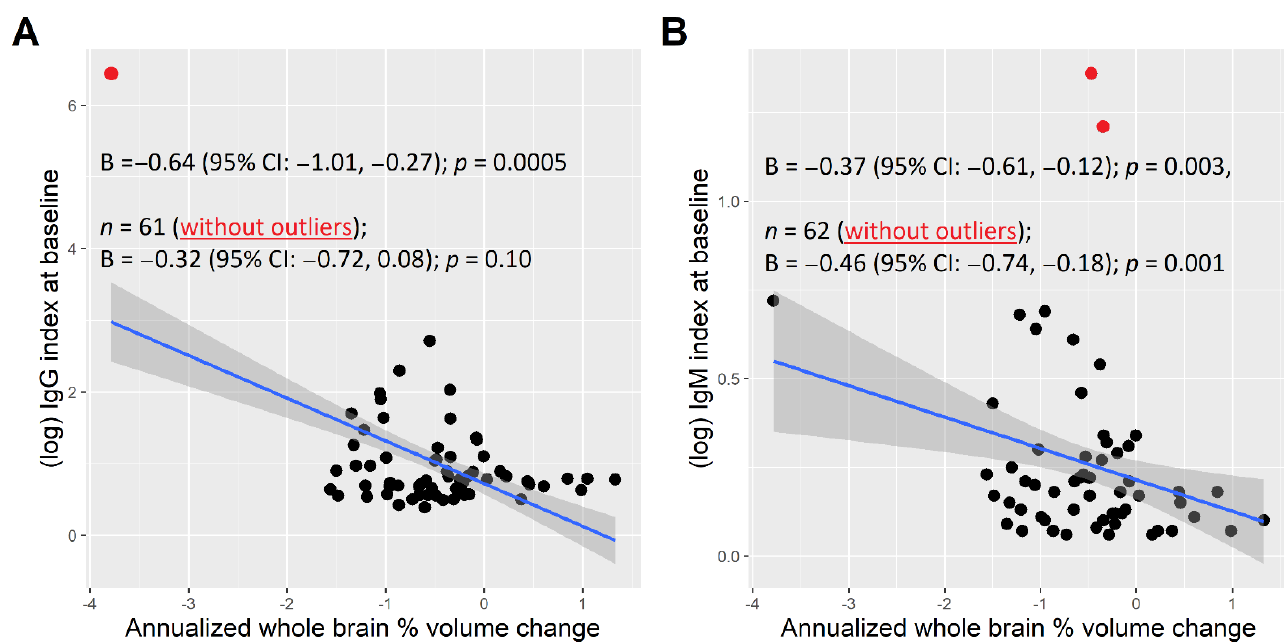
Figure 4. Association between the baseline IgG ( A ) and IgM indices ( B ) and brain % volume loss over the follow − up. Shown are the regression lines (in blue) with the confidence intervals (in grey). The values of the IgG/M indices greater or less than 2.0 standard deviations from the mean were defined as the outliers (in red). A multivariable mixed model with a fixed slope and random intercept specified for each patient adjusted for age and disease duration at the baseline exam, EDSS at the baseline exam and years between the baseline and follow - up timepoint.